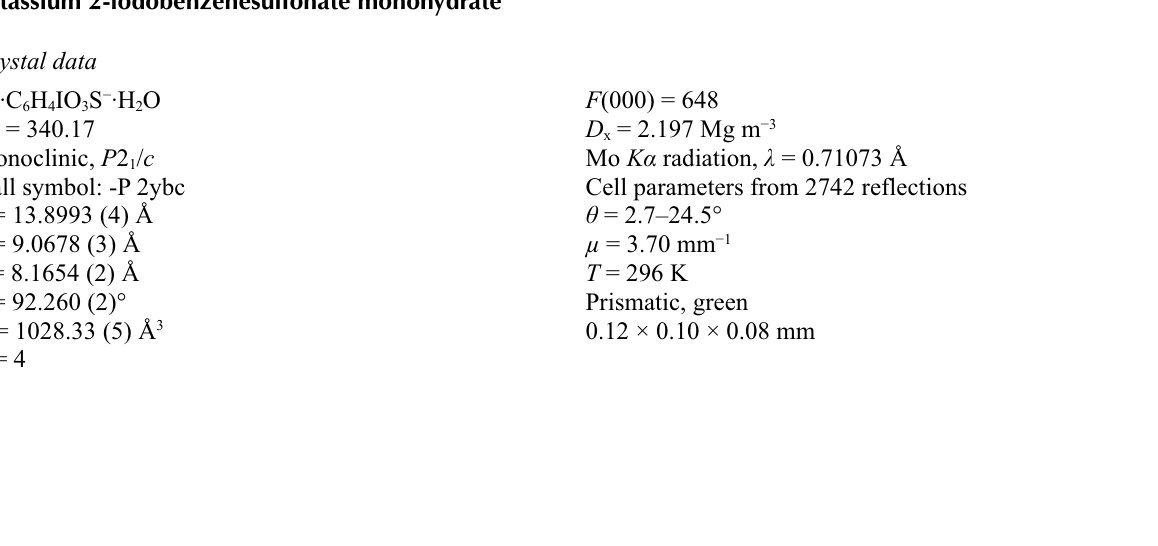
A view along the b axis of the crystal packing of the title compound [The C-bound H-atoms have been removed for